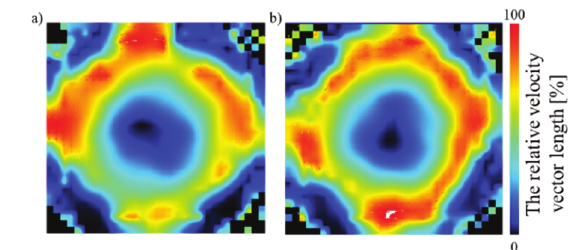
Fig. 19. Turbulence velocity at CO 2 injection pressure equal to: a) 6 bar, b) 10